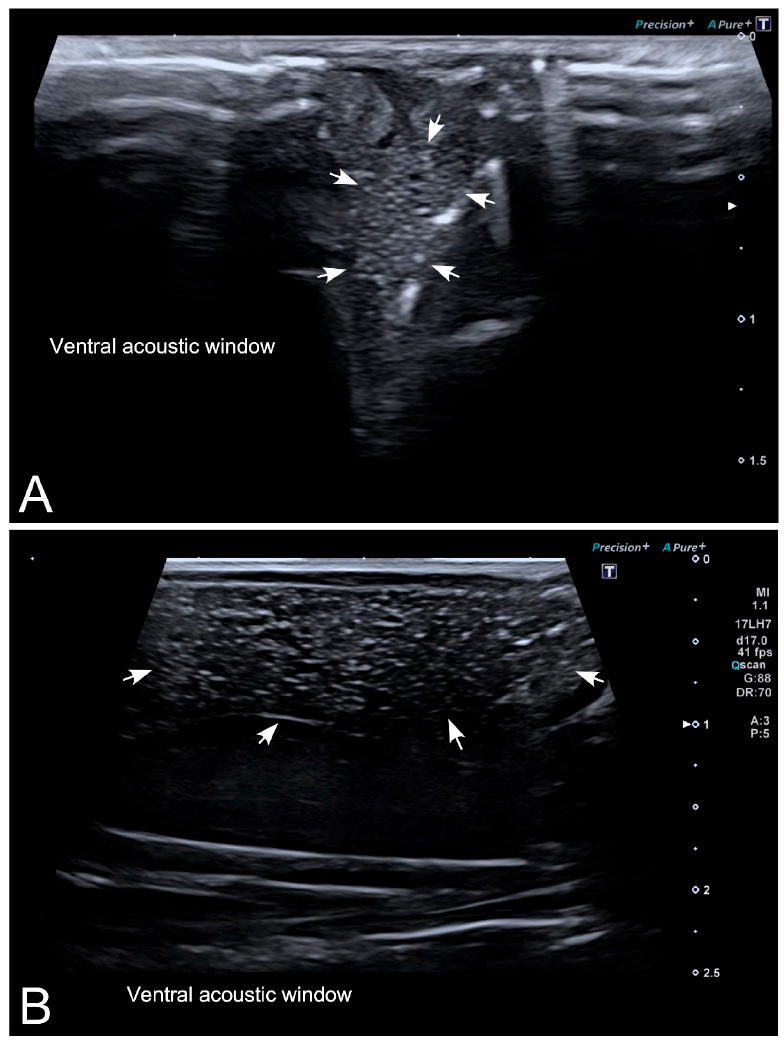
Figure 4. Representative high-resolution ultrasound (HR-US) images of a female Kaloula pulchra obtained in the transverse plane ( A ) and a female Xenopus laevis ( B ) obtained in the longitudinal plane using, in both cases, a ventral acoustic window. Follicles appeared as a complex of anechoic or hypoechoic rounded or oval areas separated by hyperechoic lines.